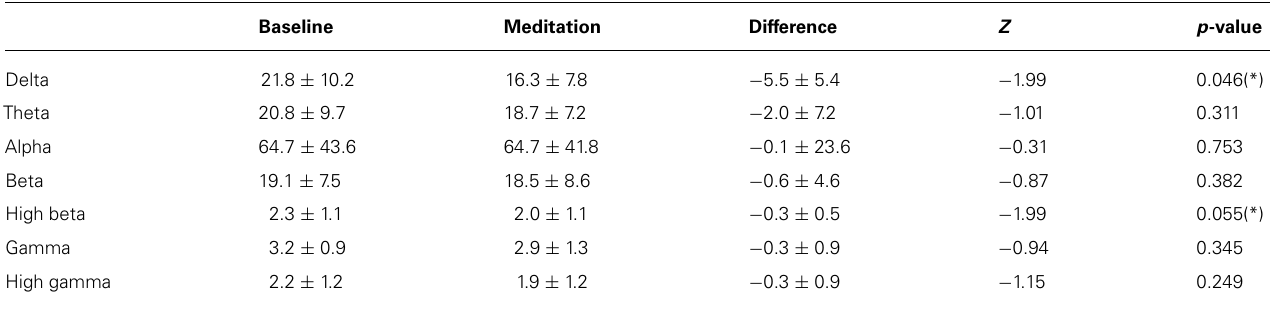
Table 1 | Mean and SD values of the EEG band absolute power for all participants for each condition with the finalWilcoxon analysis. Baseline